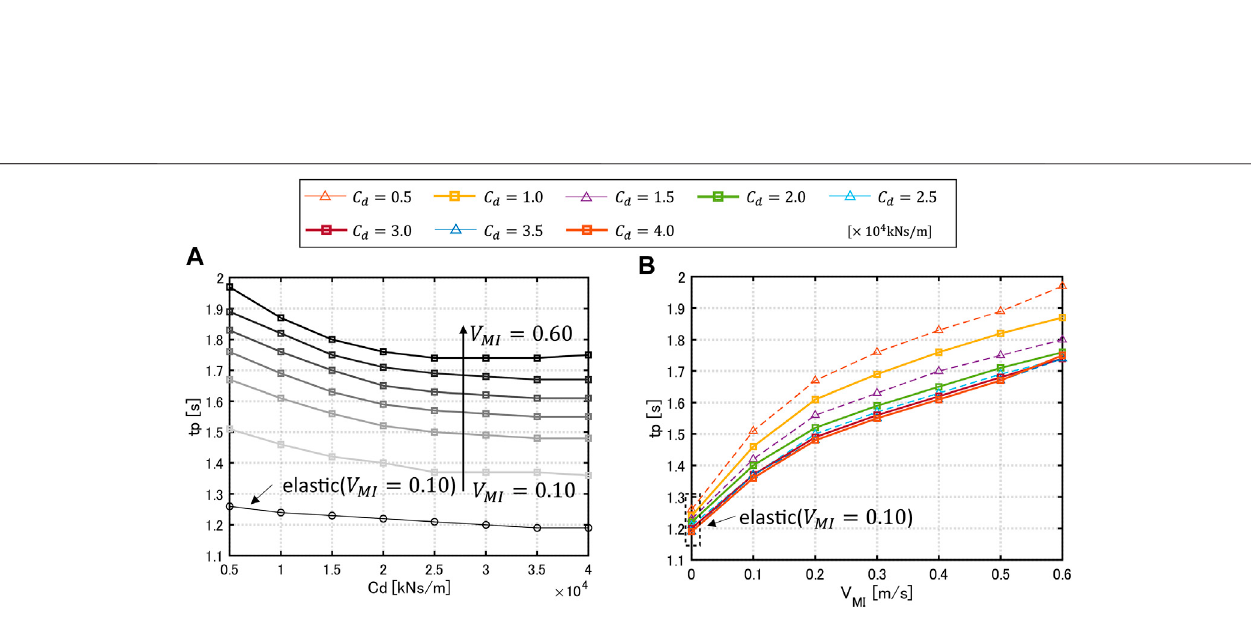
Frontiers in Built Environment |